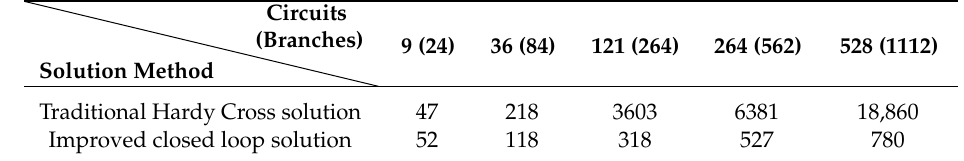
Table 3. Comparison of the iterative time (ms) for ventilation networks with di ff erent branches using the traditional Hardy Cross solution method with the improved closed loop solution method.